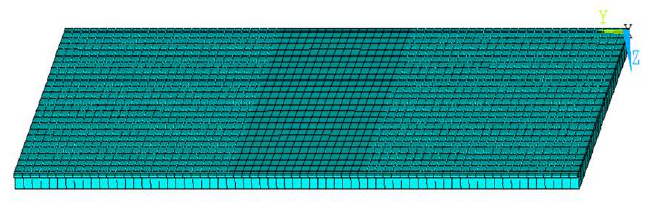
Figure 11. Finite elements model.